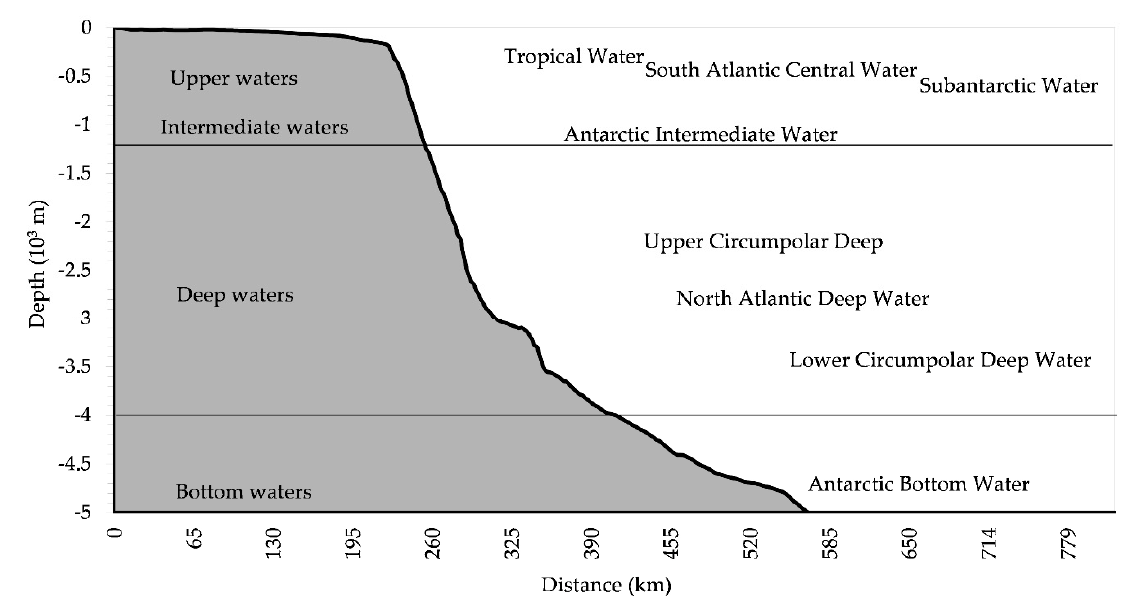
Figure 3. Simplified oceanographic profile with the bathymetric distribution of the different water masses along the Uruguayan continental margin.